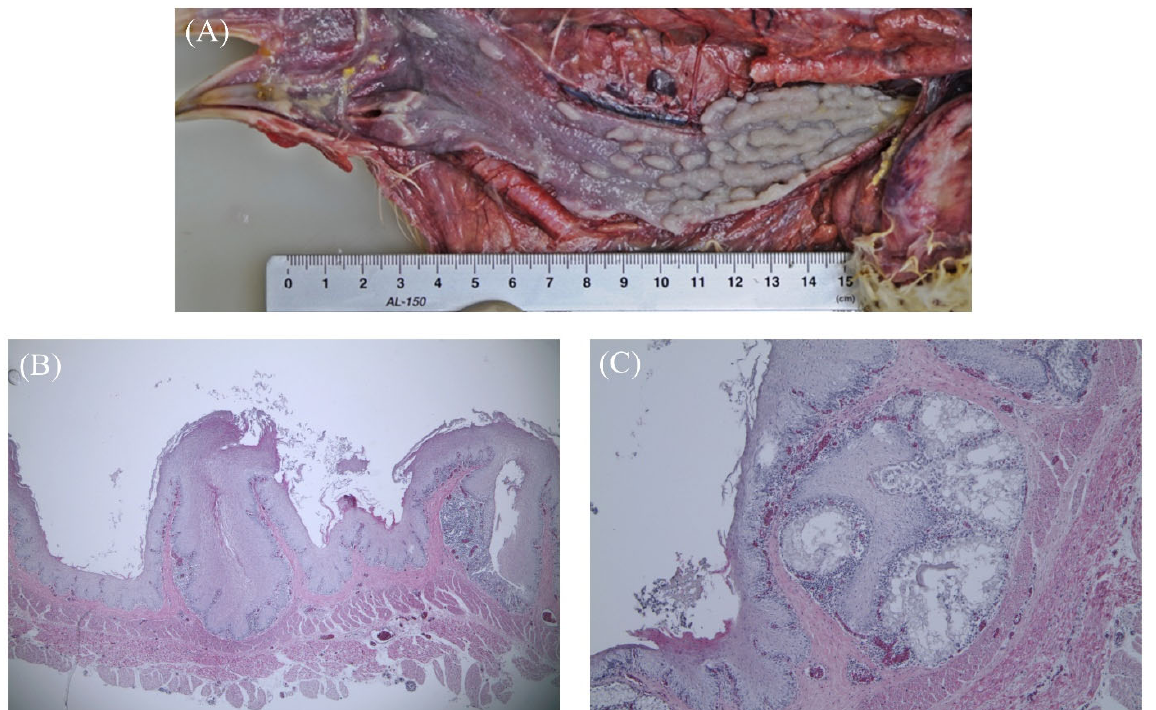
Figure 1. Squamous metaplasia (vitamin A deficiency) in 27-week-old chickens. ( A ) Distended, impacted mucosal-gland-like pustules in the esophagus. ( B ) Squamous metaplasia has replaced all and distention has resulted from occlusion of opening and accumulation of keratin and cellular debris in the lumen (40x). ( C ) Lymphocyte infiltration and hemorrhage in the esophageal gland (40x). Histopathologically, the stratified squamous epithelial cells of the esophagus were